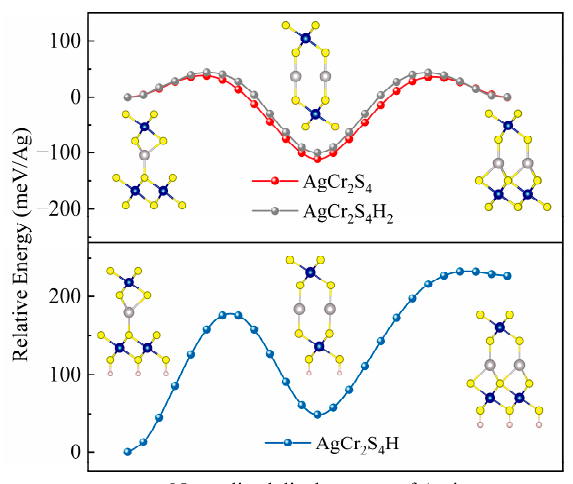
Figure 5. The switching paths of AgCr 2 S 4 H 2 (grey), AgCr 2 S 4 H (blue), and AgCr 2 S 4 (red) as simulated by NEB. Ag, Cr, S, and H ions are represented by gray, dark blue, yellow, and white balls in the illustrations, respectively.